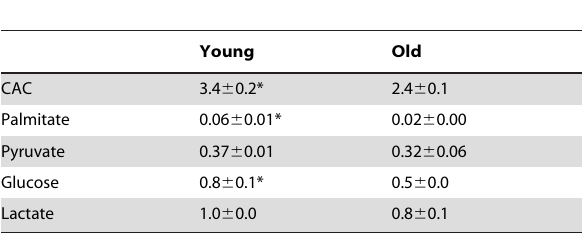
Table 5. Flux rates for total citric acid cycle (CAC) and individual substrates at standard afterload.